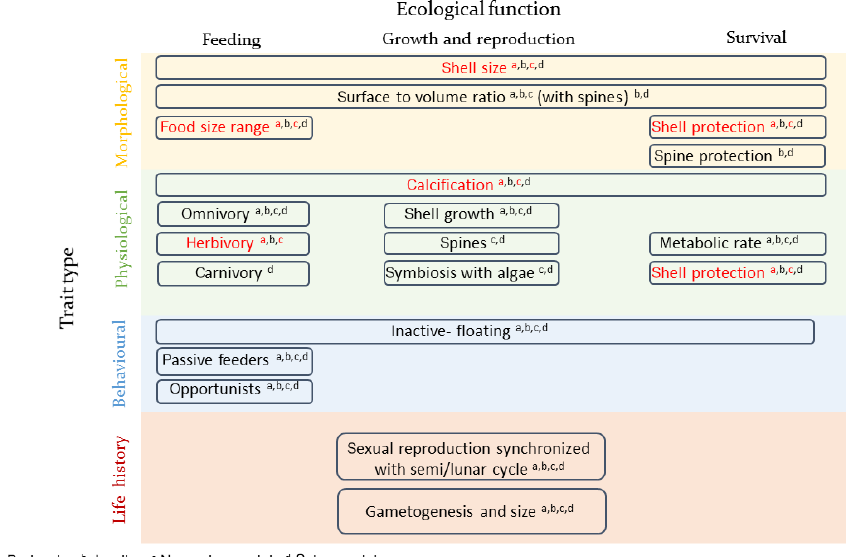
Figure 1. Schematic presentation of planktonic foraminifera traits and trade-offs. The examined traits of the present study are shown in red. The presentation of planktonic foraminifera’s traits was inspired from the topology of zooplankton traits proposed by Litchman et al.